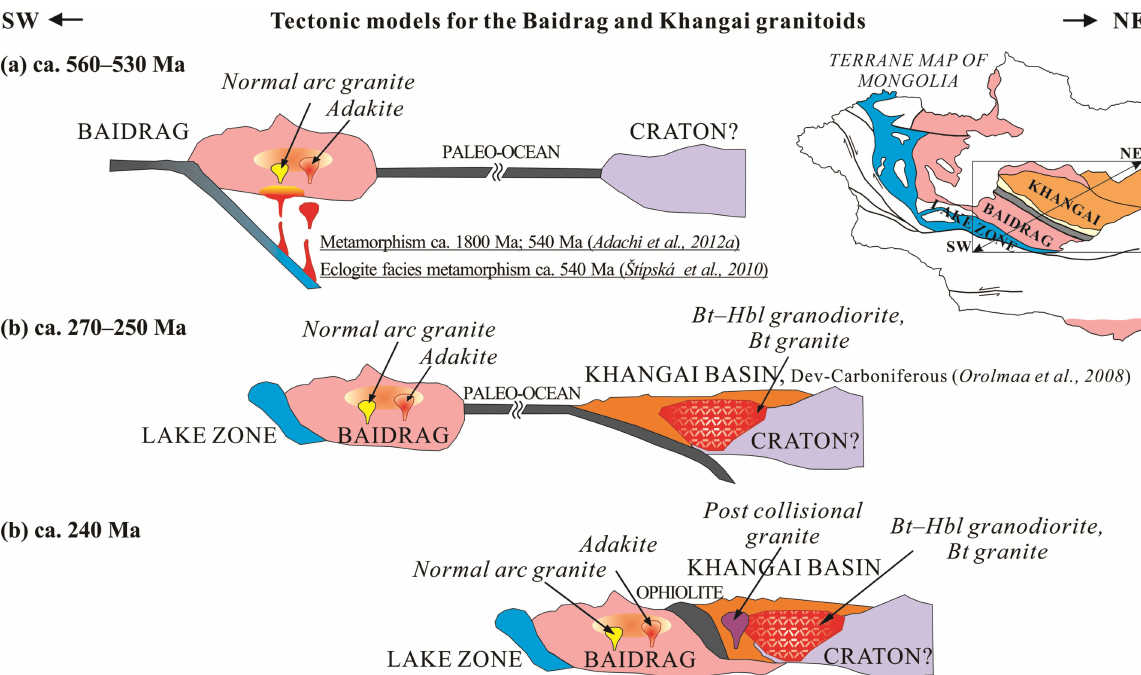
Fig. 13. Model showing the evolution of the study area. (a) Arc-type magmatism in the Baidrag area involving melting of the subducting oceanic slab and lower crust. (b) Arc-type magmatism in the Khangai area, forming biotite–hornblende granodiorite and biotite granite magmas. (c) Closure of the ocean and generation of post- collisional granites. Inset map shows the modern location of each of these terranes (Badarch et al.,